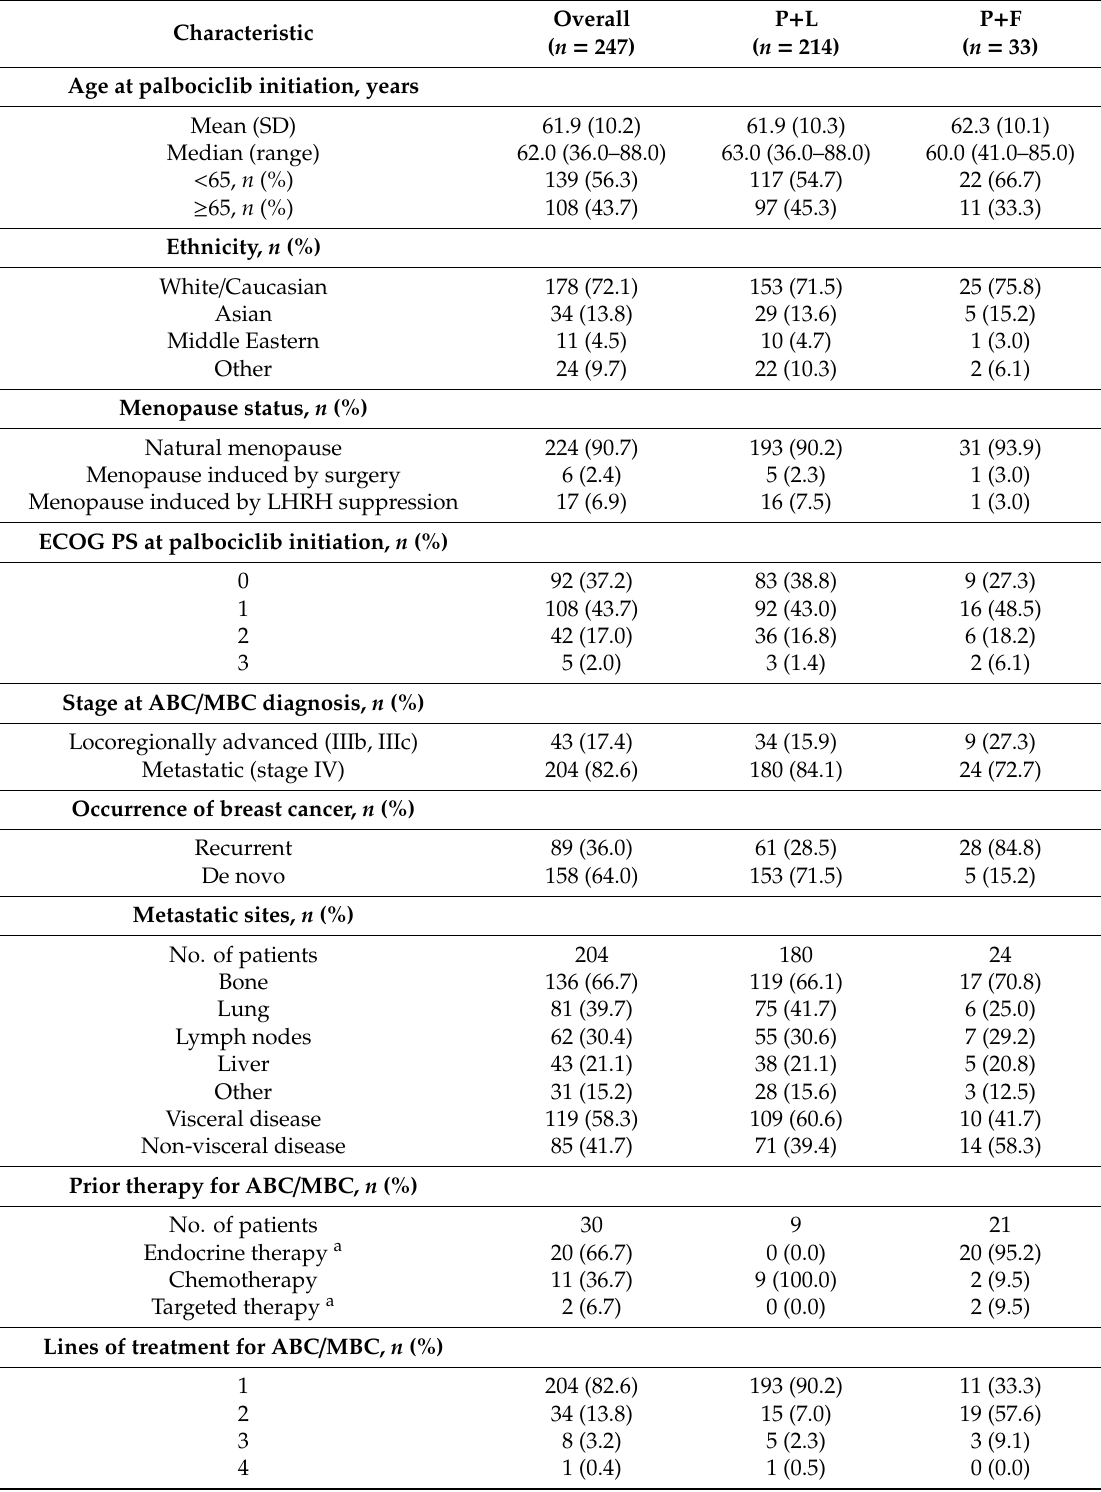
Table 2. Patient demographic, clinical, and treatment